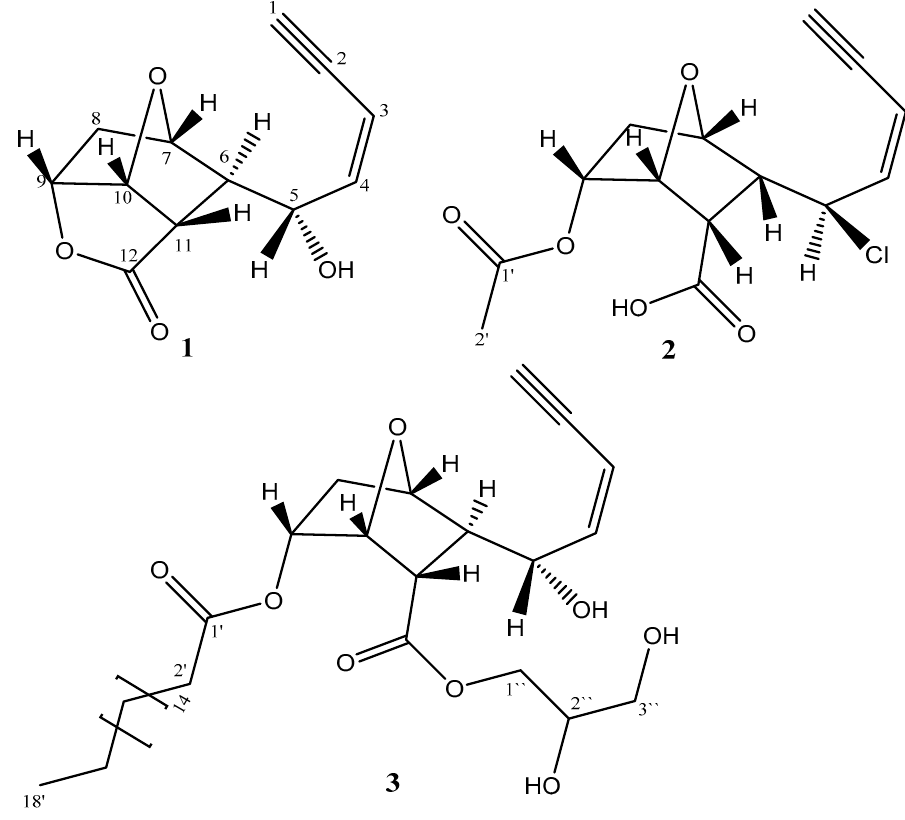
Figure 1. Structures of the isolated compounds 1 – 3.